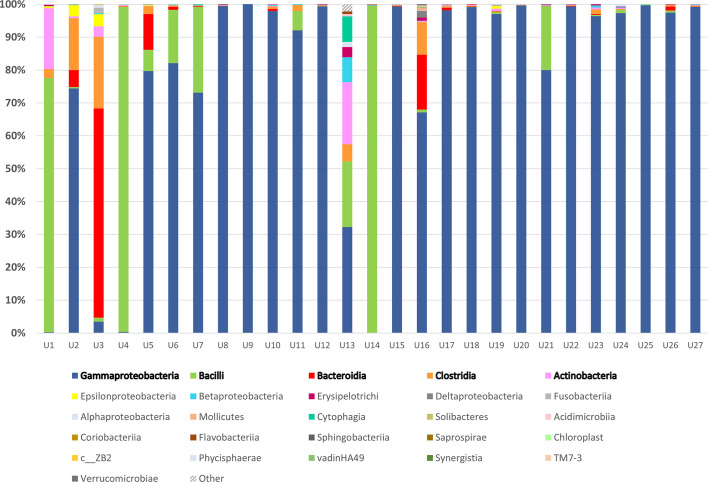
16S rRNA sequencing of urine samples from patients diagnosed with UTI: Taxonomic representation of bacterial classes as identified by sequencing of V3 and V4 region of 16S rRNA gene. The most abundant classes were marked in bold and sequences belonging to group marked as “Other” were not matched to any sequence in Greengenes database.